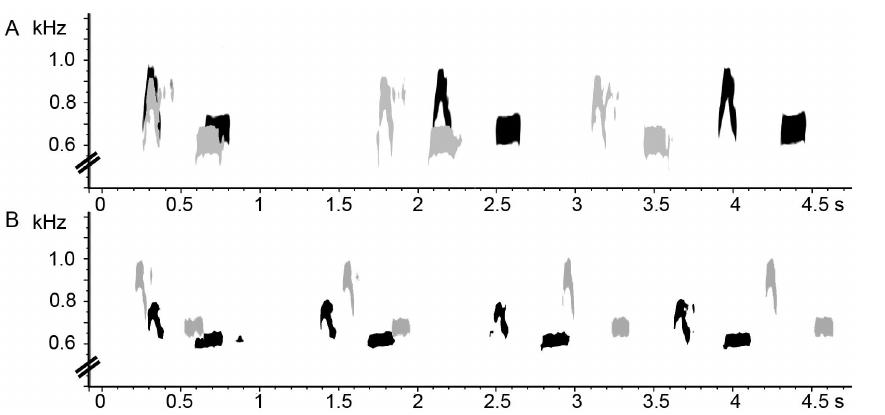
Figure 3. Spectrograms of male cuckoo calls illustrating between-individual variation and within-individual consistency. Ordinary calls of male cuckoos differ individually, showing consistent differences in time duration (A) and frequency range (B) of their calls. Colors of spectrograms in each panel represent different individuals.